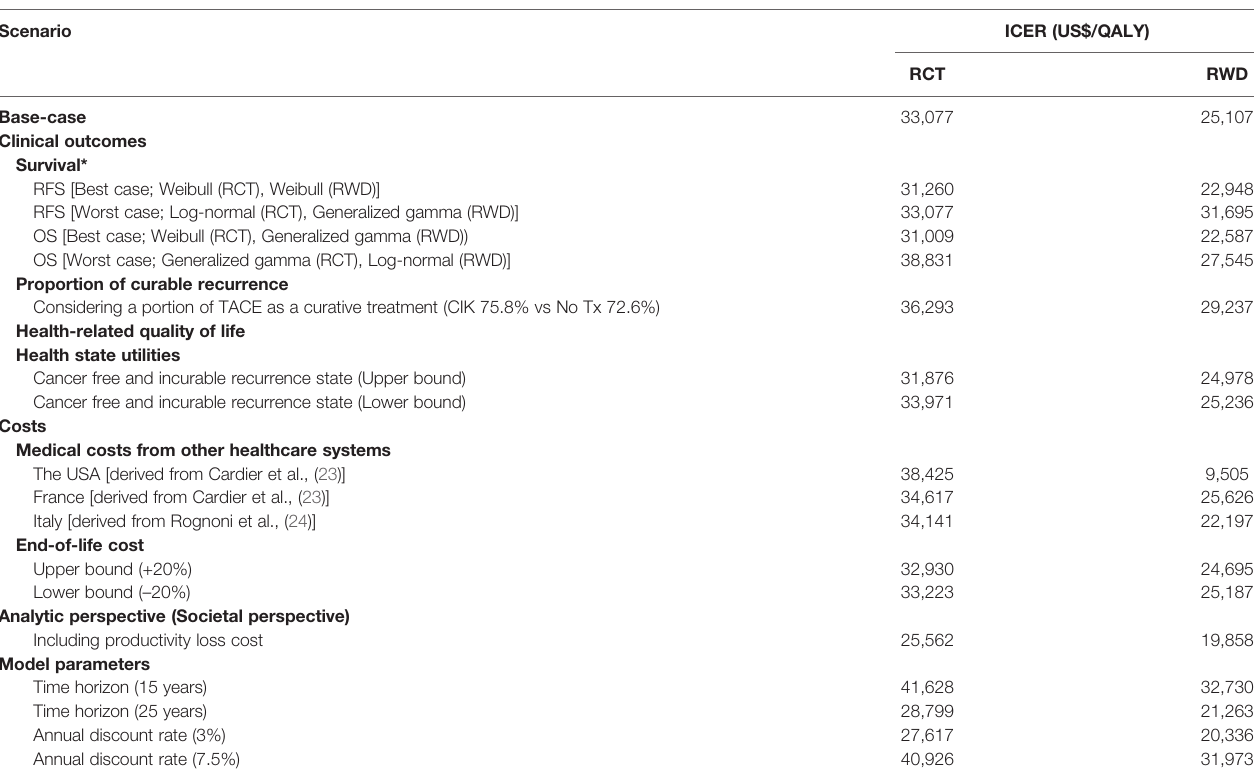
TABLE 3 | Deterministic sensitivity